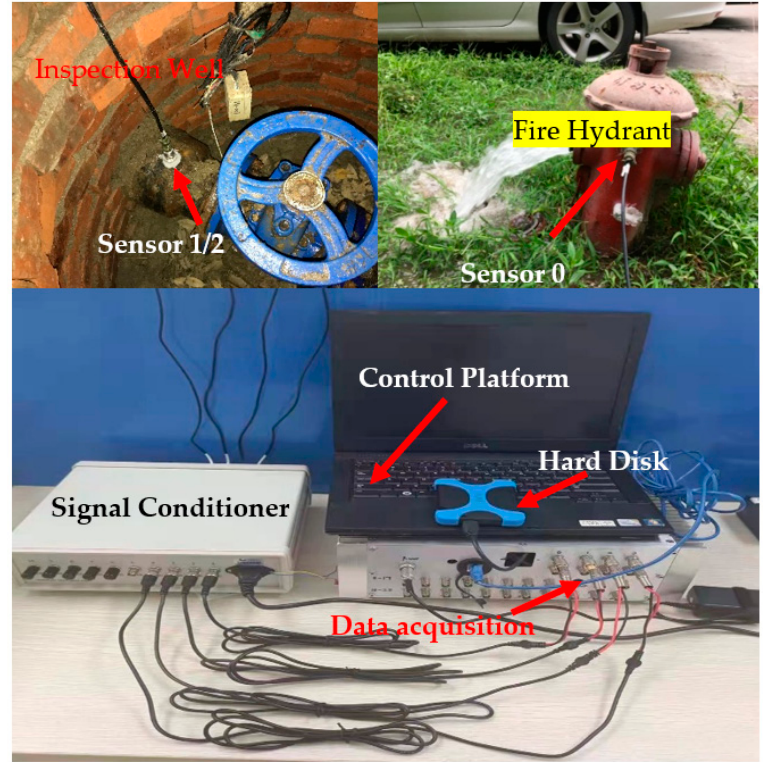
Table 3. Comparison between the identified values and the test values for soil parameter.